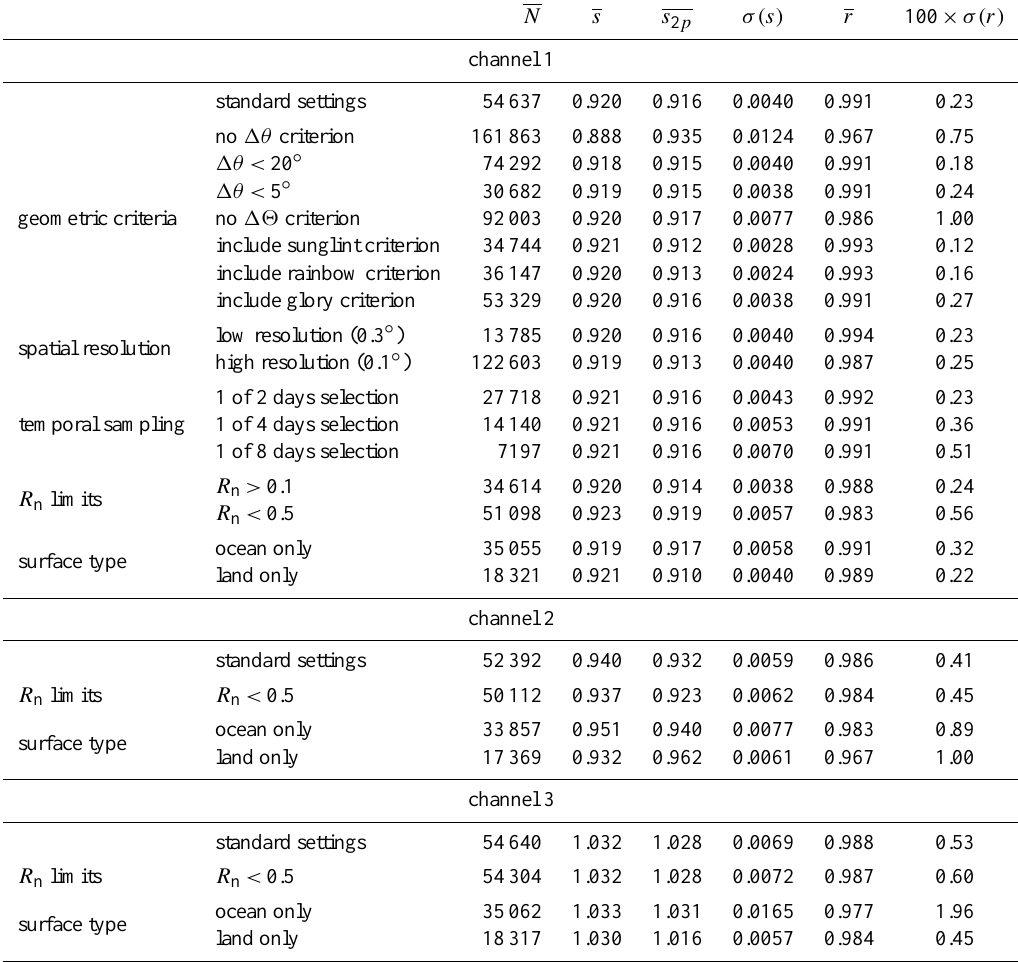
Table 2. Sensitivity of regression statistics a to pixel selection criteria and sampling strategies. Results are for SEVIRI-Meteosat-9 to MODIS- Aqua fits for the years